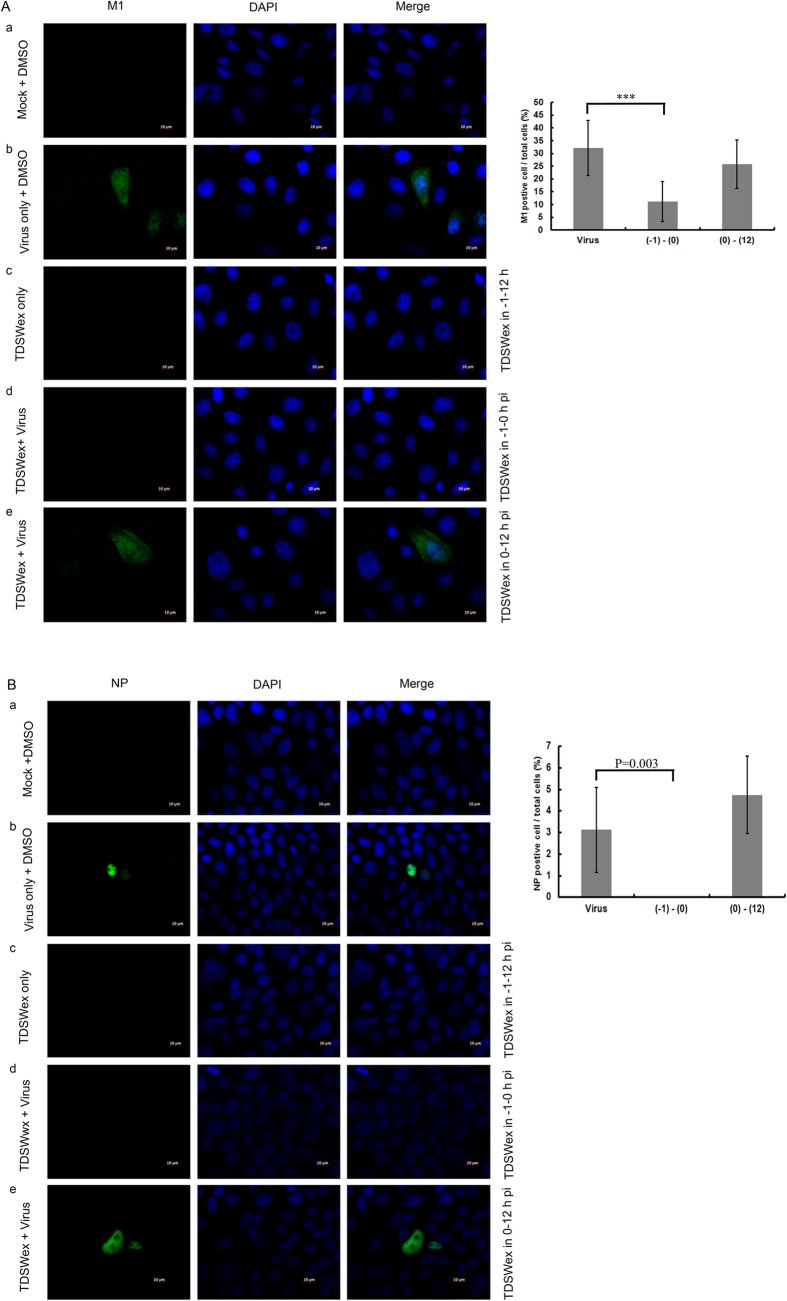
Detection of viral protein expression by immunofluorescence microscopy.MDCK cells were infected with influenza A/WSN/33 (MOI = 0.01). TDSWex (0.1 mg/mL) or DMSO (0.05%) was added to infected cells during or after adsorption and the cells were fixed at 12 h p.i. The green foci represent viral M1 (left column of Fig. 3a) or viral NP (left column of Fig. 3b). The middle column shows nucleus staining with DAPI. The viral protein and DAPI images are merged in right columns. (a) Mock: mock infection with DMSO; (b) Virus only: cells infected with virus; (c) TDSWex only: cells not infected with virus but incubated with TDSWex at –1 to 12 h p.i.; (d) TDSWex + Virus: cells infected with virus and incubated with TDSWex during infection (–1 to 0 h p.i.); (e) TDSWex + Virus: cells were infected with virus and incubated with TDSWex after infection (0 to 12 h p.i.). Right, immunofluorescent foci of M1 and NP of about 300 individual cells from 6 fields were counted in each condition. The ratio of M1- or NP-positive cells to the total cell number was then determined. The data were presented as mean ± SD of the results of two independent experiments. ***p < 0.001 compared to virus only control.